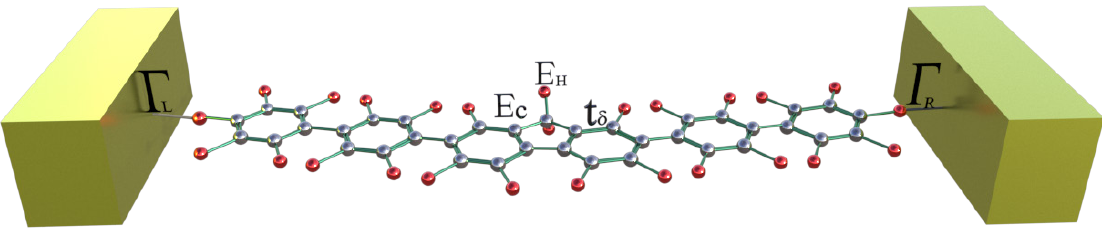
Figure 1. (Color online) Flat 2,7-Di([1,1 (cid:48) -biphenyl]-4-yl)-9H-fluorene molecular aromatic